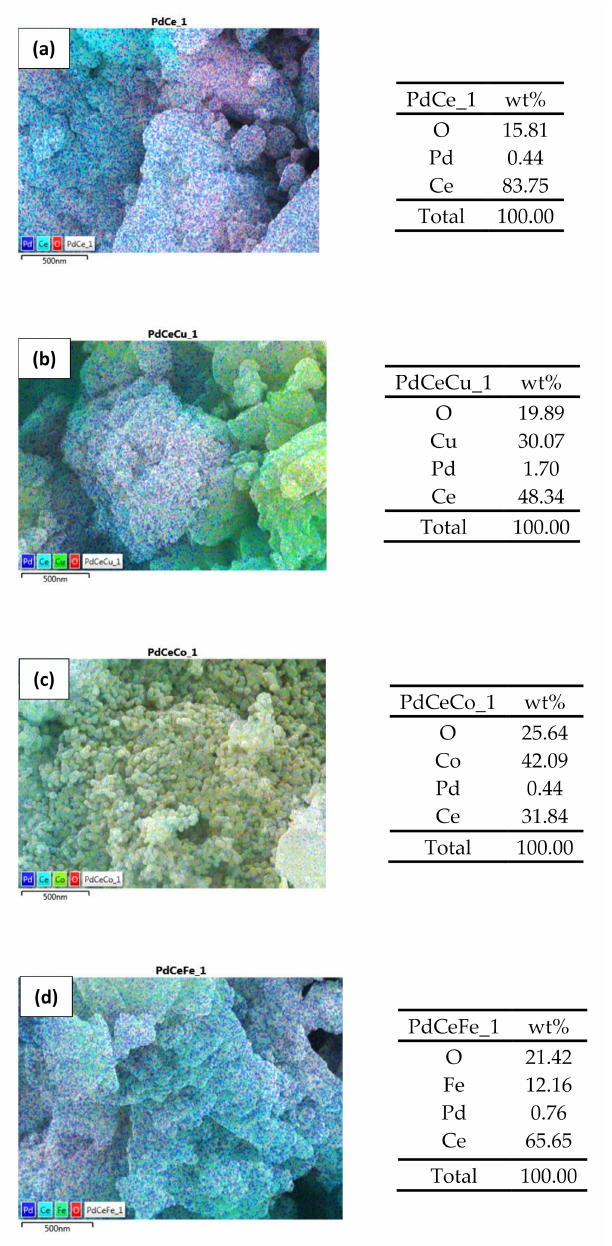
Figure 2. SEM-EDX images and corresponding wt% of each element of ( a ) Pd/CeO 2 , ( b ) Pd- CuO/CeO 2 , ( c ) Pd-Co 3 O 4 /CeO 2 , and ( d ) Pd-Fe 2 O 3 /CeO 2